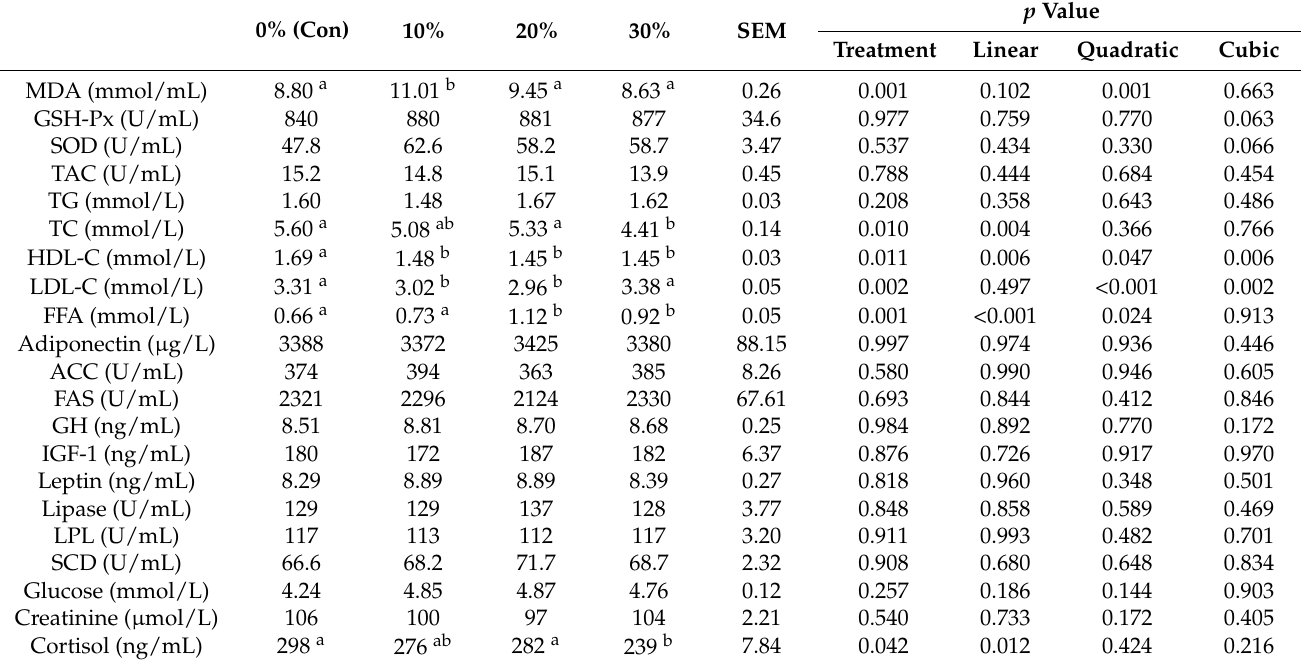
Table 3. Effects of 0% (Control), 10%, 20% and 30% Agriophyllum squarrosum on serum-biochemical indices in Tan lambs (means ±